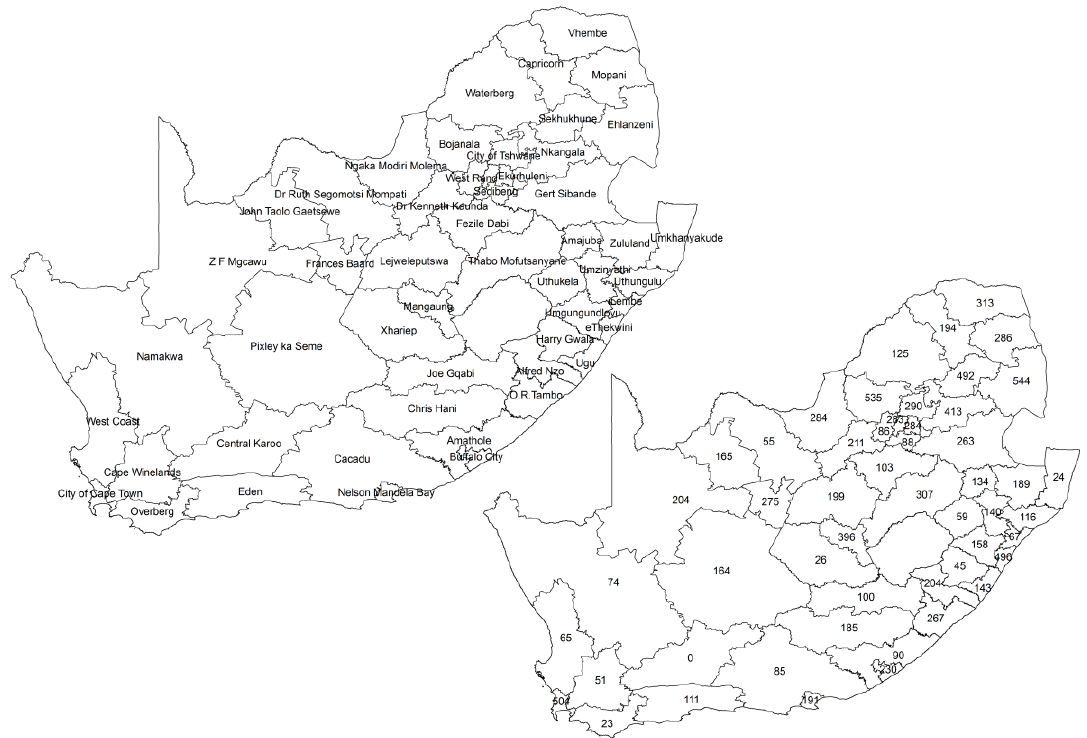
Figure 1. The South African map showing the district names and sample sizes: South African Demographic and Health Survey, 2016.